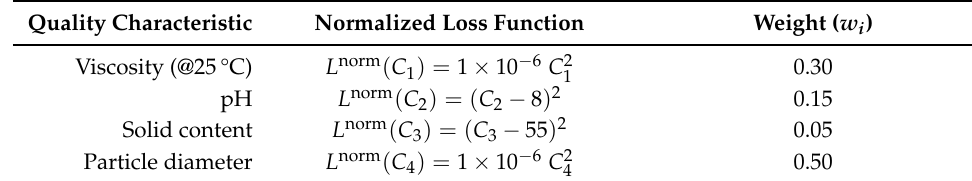
Table 3. Normalized loss functions and relative